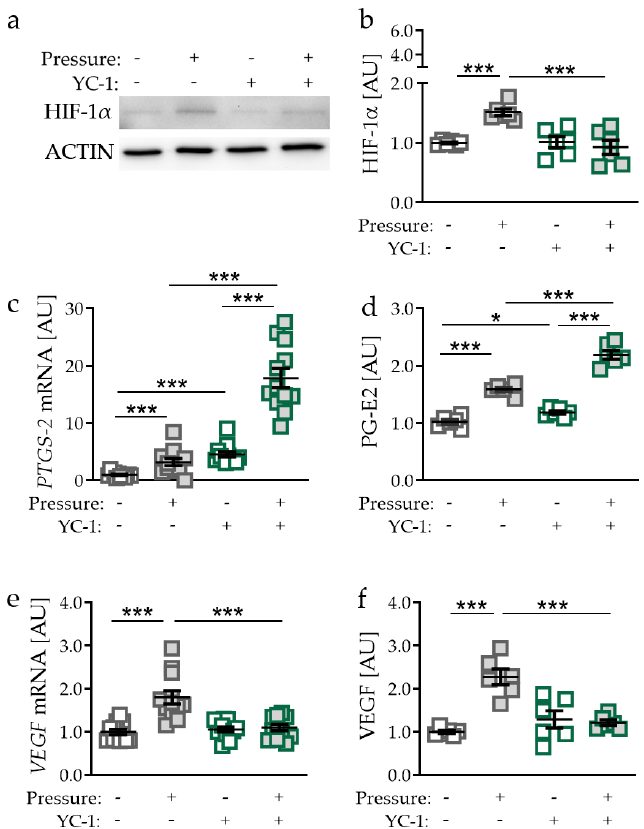
Figure 3. Effects of compressive strain with and without YC-1 treatment (constitutively inhibiting HIF-1 α ) on HIF-1 α protein expression ( a , b ), PTGS-2 / PG-E2 expression ( c , d ), and VEGF expression ( e , f